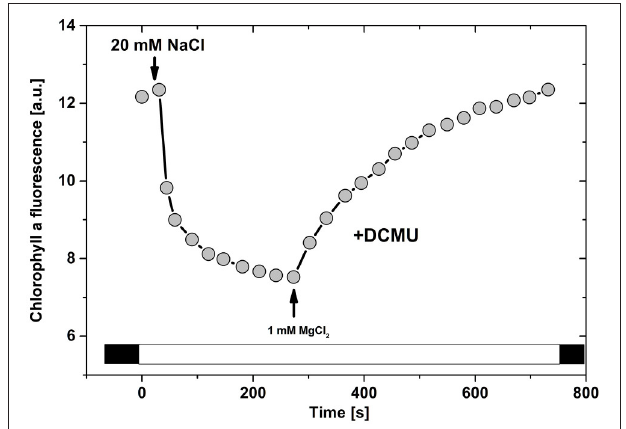
FIGURE 4 | Ion induced changes in variable chlorophyll a fluorescence in isolated thylakoids (data adapted from Vandermeulen and Govindjee, 1974 ). Time course of cation induced changes in chlorophyll a fluorescence in oat chloroplast suspension containing 5 µ g chlorophyll ml − 1 , and 5 µ M DCMU in low salt buffer. Subsequently, 20 mM NaCl and 1mM MgCl 2 were added (see